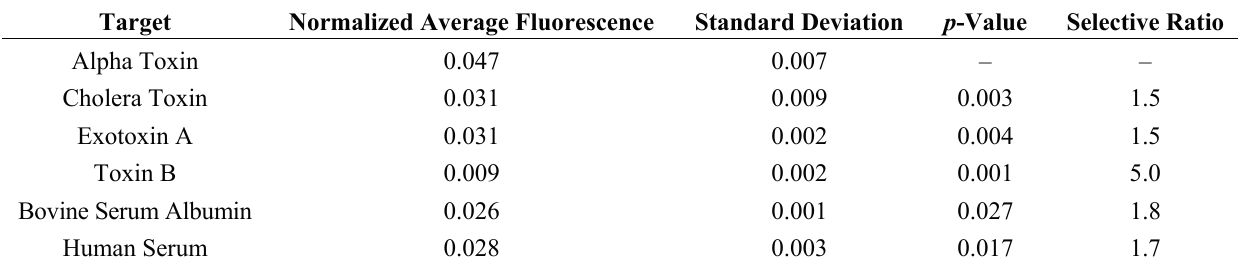
Table 4. Cross-reactivity data of R12.06 ssDNA